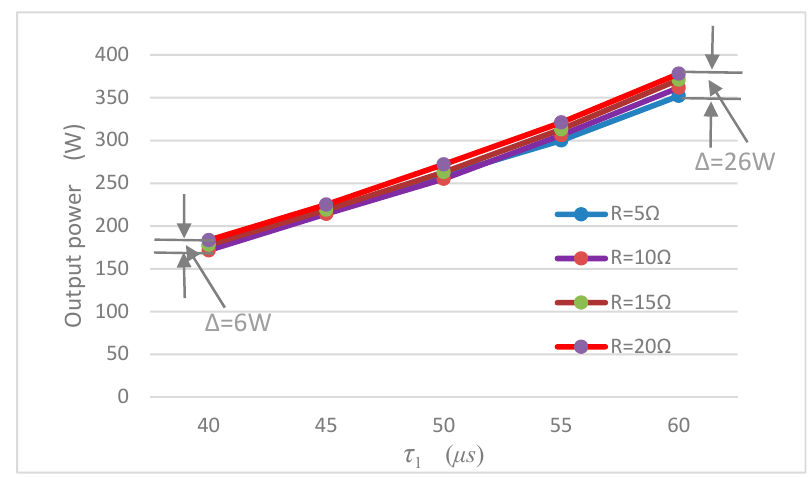
Figure 15. Output power versus the energy injection period τ 1 under condition of U DC = 300 V and k = 0.2.